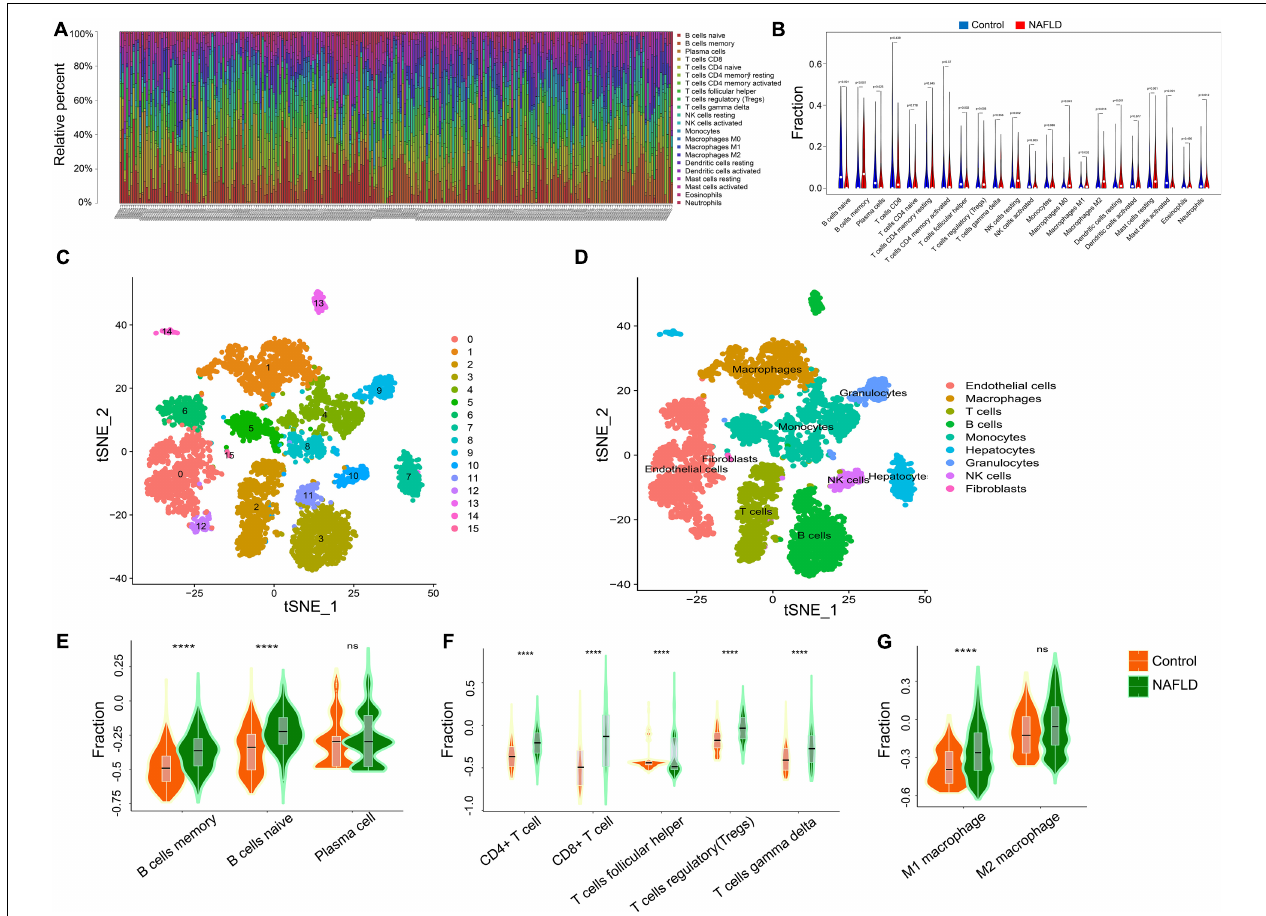
FIGURE 3 | Immune landscape of NAFLD. (A) The percentage of 22 types of immune cells in the NAFLD and control groups. (B) The difference of immune cells between NAFLD and control group. (C) The TSNE algorithm was used for dimensionality reduction and finally 16 cell clusters were successfully classified. (D) All 16 clusters of cells were annotated by Celldex package according to the composition of the marker genes. (E) Enrichment scores of B cells subpopulations at the single-cell level. (F) Enrichment scores of T cells subpopulations at the single-cell level. (G) Enrichment scores of Macrophages subpopulations at the single-cell level. **** p <